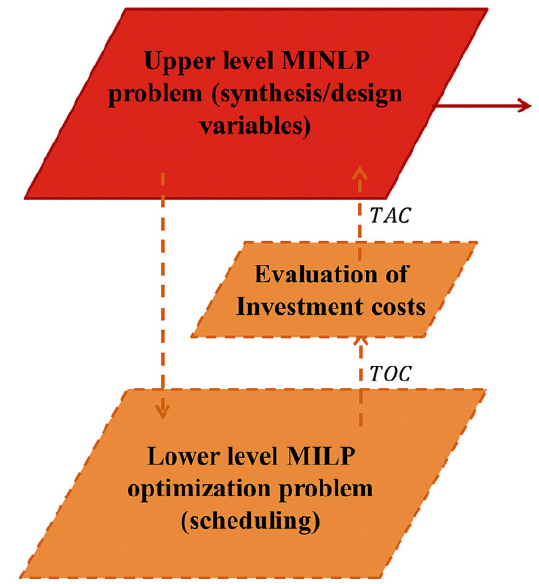
Figure 7. Scheme of the two-level optimization process. The TOC, minimized at the lower level,